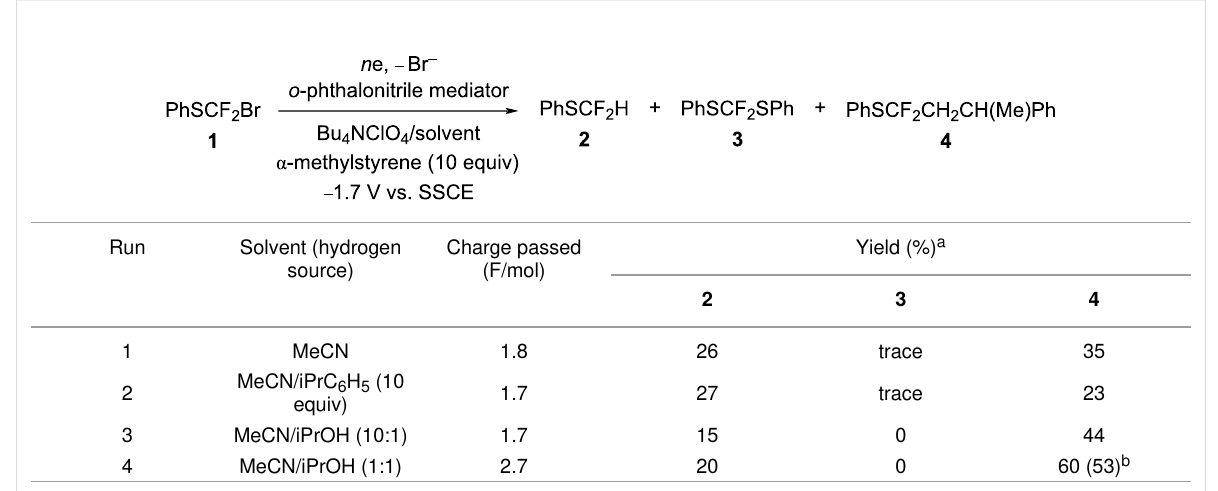
Table 4: Indirect cathodic reduction of compound 1 with o -phthalonitrile in the presence of α -methylstyrene in MeCN containing cumene or isopropyl